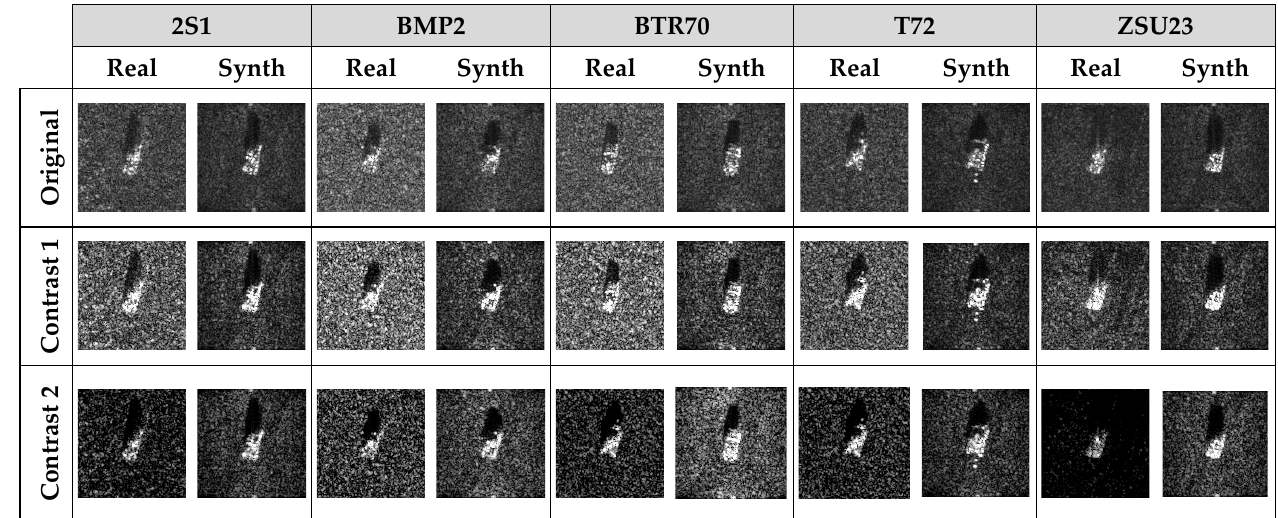
Figure 8. Data augmentation by introducing images with various contrast levels.